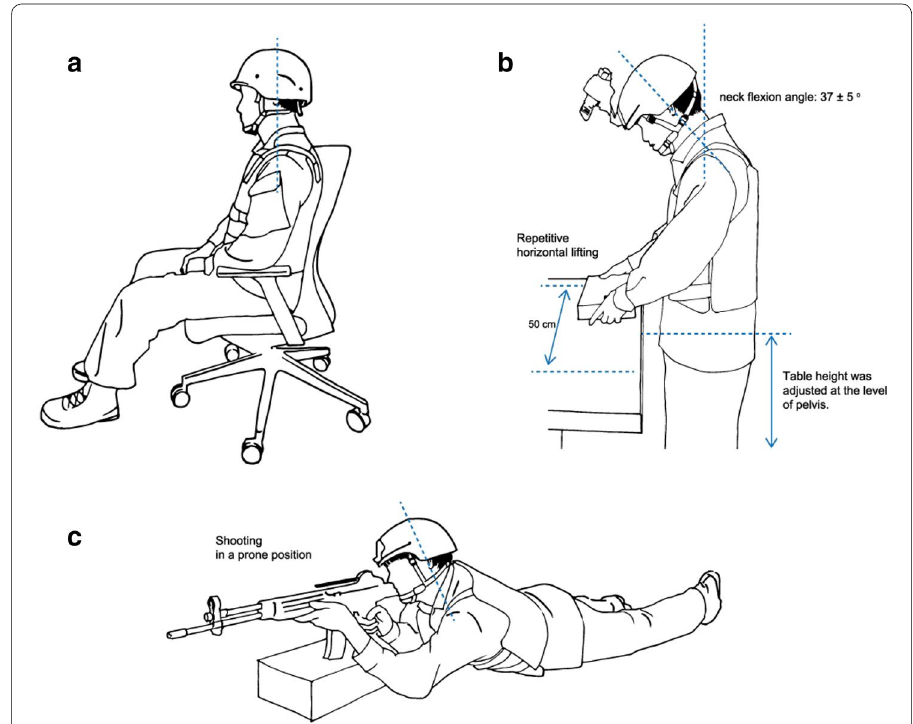
Fig. 1 Schematic diagram of simulated military activities and postures: Sitting in a chair looking in the forward direction ( a ), horizontal lifting on a table ( b ), and shooting in the prone position ( c